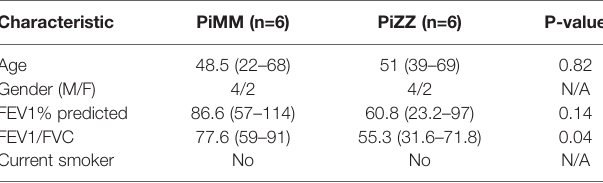
TABLE 1 | Characteristics of controls and AATD